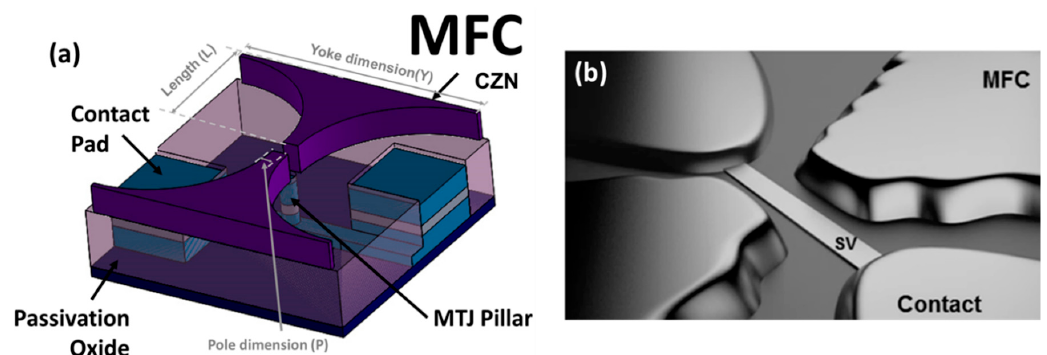
Figure 4. ( a ) Schematic view of MFCs with funnel shape geometry and respective integration with a patterned MTJ sensor (before the top contact deposition). Reprinted with kind permission of The European Physical Journal (EPJ); ( b ) Illustration of steep profile MFCs close to a SV single sensor. Reprinted with permission from Leitao D.C. et al. , Sensors 2015, 15 , 30311–30318. Copyright 2015 MDPI.